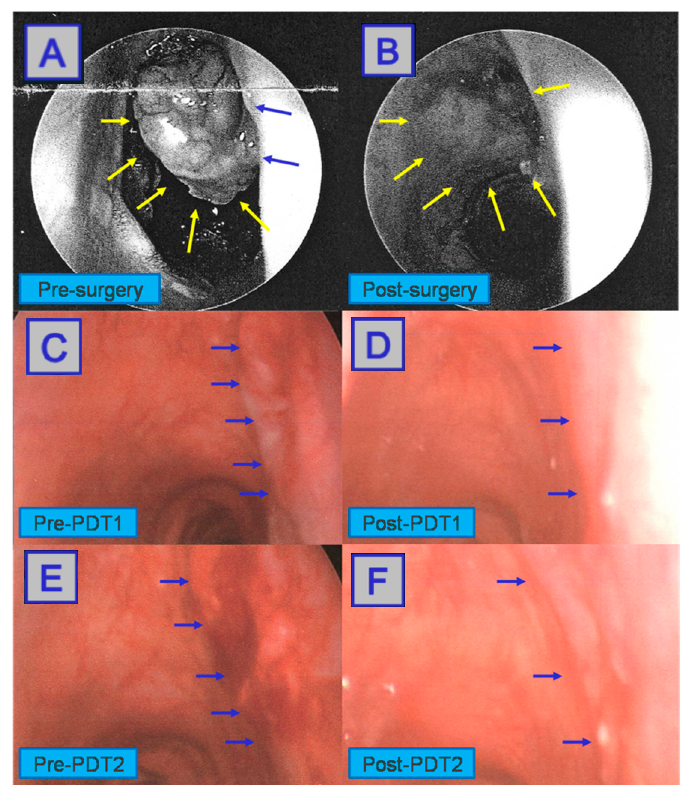
Figure 14. Surgical removal of the initial tumour, shown during intraoperative panendoscopy ( A ) and ( B ). Some tumour regrowth shown ( C ), subsequently treated with PDT. A reduction in regrown tumour bulk is seen ( D ). A second round of PDT carried out on tumour regrowth ( E ), followed by a complete response ( F ). Reprinted with permission from ref. [86]. Copyright 2010 Photodiagnosis Photodyn. Ther.